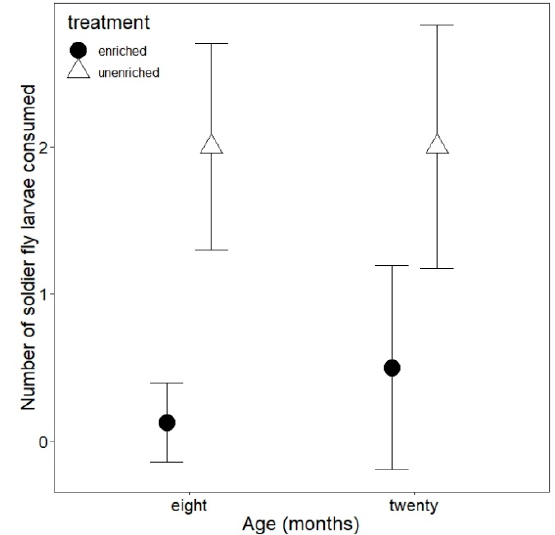
Figure 3. Number of black soldier fly larvae ( Hermetia illucens ) consumed by enriched and unenriched captive-reared eastern box turtles ( Terrapene carolina ) when eight and 20 months old. Symbols represent means and bars are 95% confidence intervals.